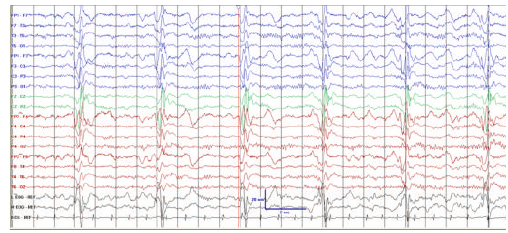
Figure 1: Electroencephalogram showing periodic epileptiform complexes consistent with